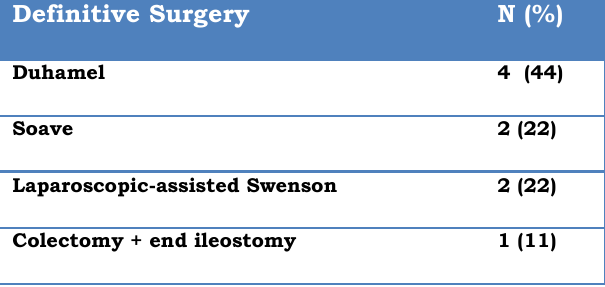
Table 2: Definitive surgery for total colonic aganglionosis (TCA)